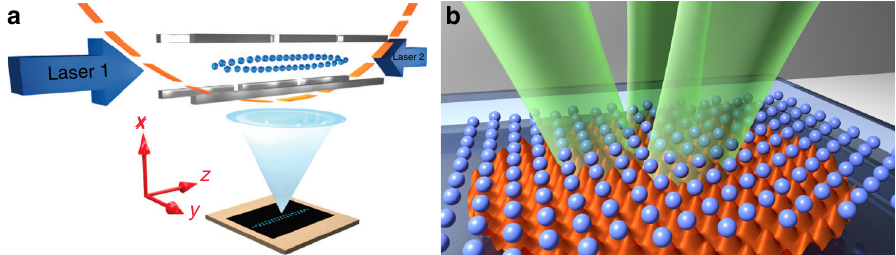
Fig. 5 Experimental con fi rmation of the Aubry transition in atomic and colloidal systems. a Sketch of an experimental setup with two interacting chains of laser-cooled YB positive ions inside a linear trap which is created by four quadrupole electrodes. The two laser beams are used for the illumination of the ions and for performing vibrational spectroscopy. The ions are imaged onto an electron multiplying CCD camera 52 . b Illustration of an extended two- dimensional micron-sized colloidal monolayer consisting of several thousand particles which are interacting with an optical substrate potential created by three interfering laser beams. Variation of the corrugation amplitude of the substrate potential is achieved by changes in the laser intensity 53 . Both experiments con fi rm the existence of a transition from a superlubric to a pinned state in agreement with